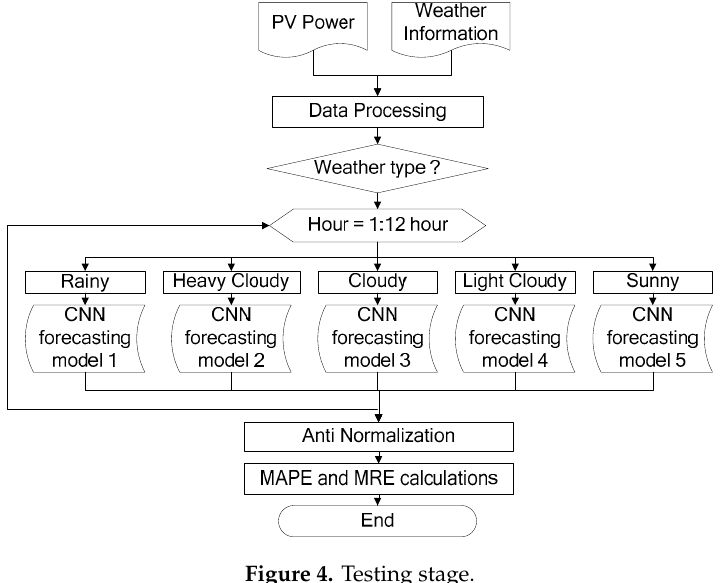
Figure 4. Testing stage.